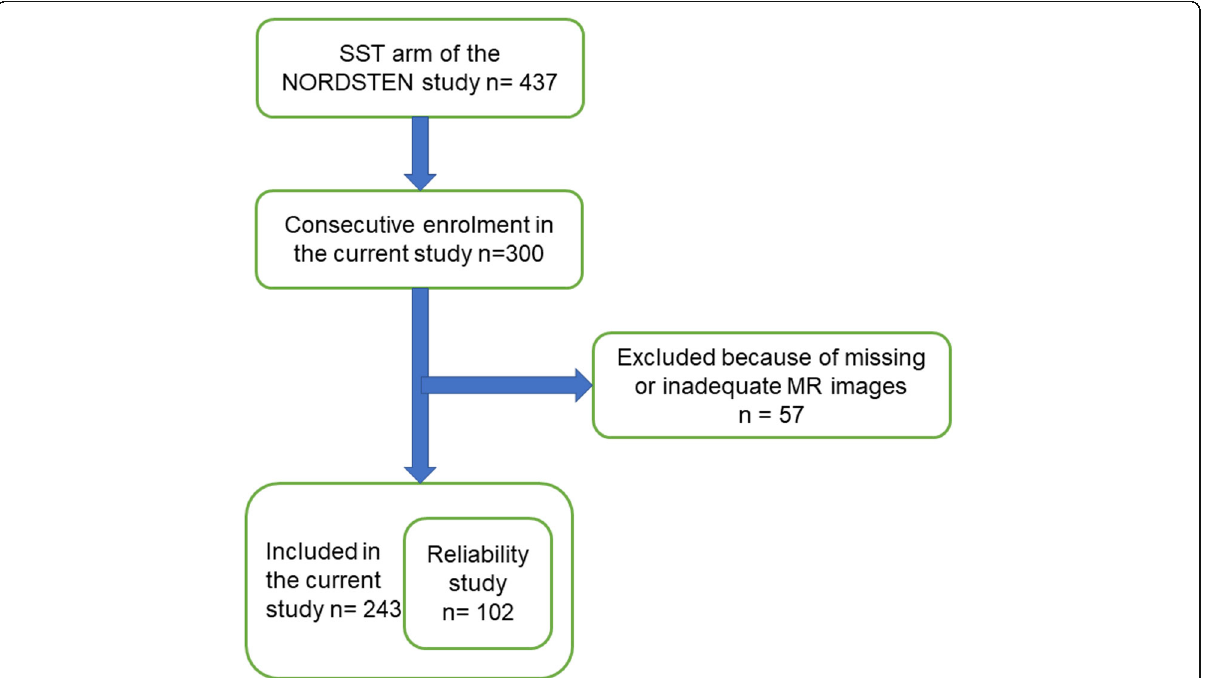
Fig. 1 The flowchart shows the patient selection process. SST Spinal stenosis trial, NORDSTEN Norwegian degenerative spondylolisthesis and spinal